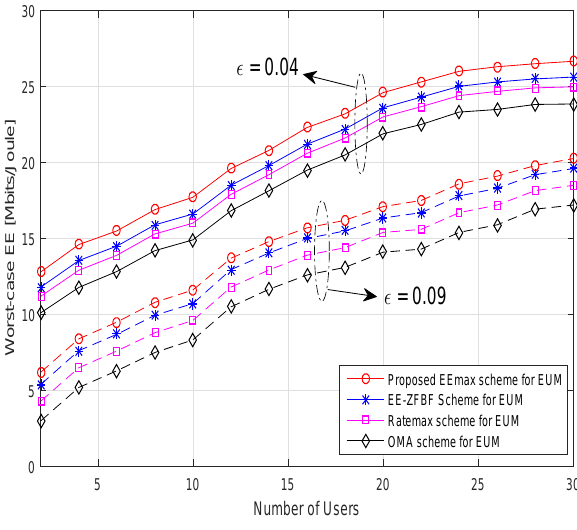
Figure 7. Worst-case EE versus number of